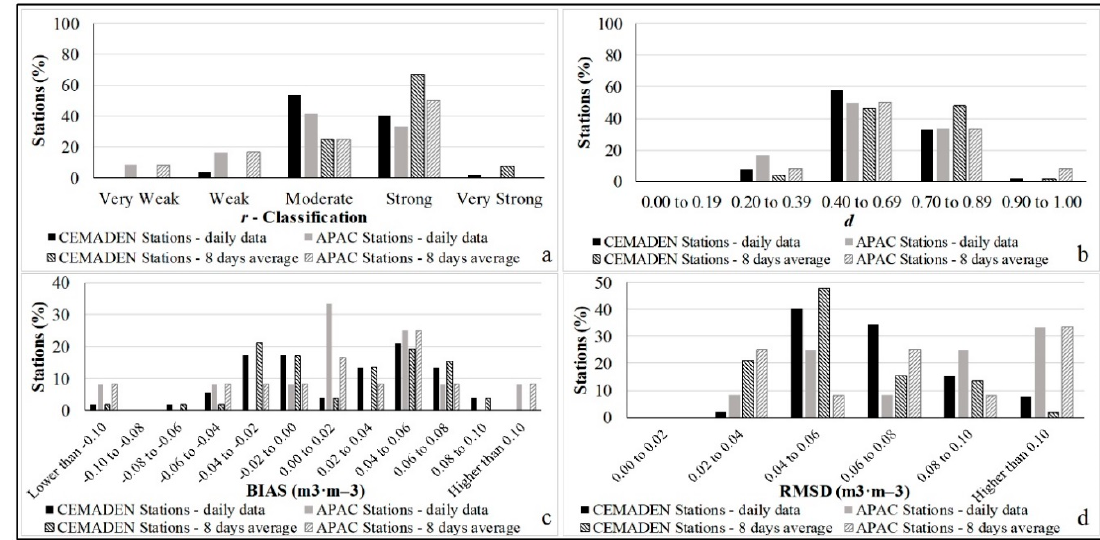
Figure 4. Frequency of occurrence of ( a ) Pearson’s r ( r ), ( b ) Willmott index ( d ), ( c ) BIAS, and ( d ) RMSD. CEMADEN = National Center for Monitoring and Early Warning of Natural Disasters.